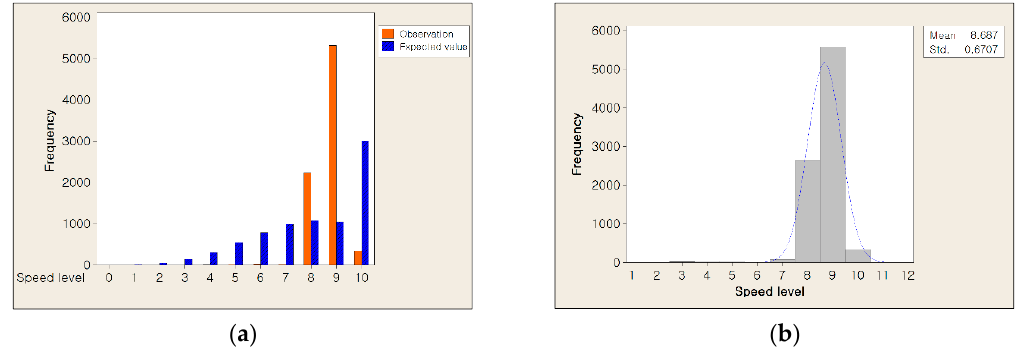
Figure 7. The analysis results of traffic flow data ( a ) Chi-square goodness of fit test result and ( b ) the distribution of observed traffic flow data mapped with Gaussian distribution.